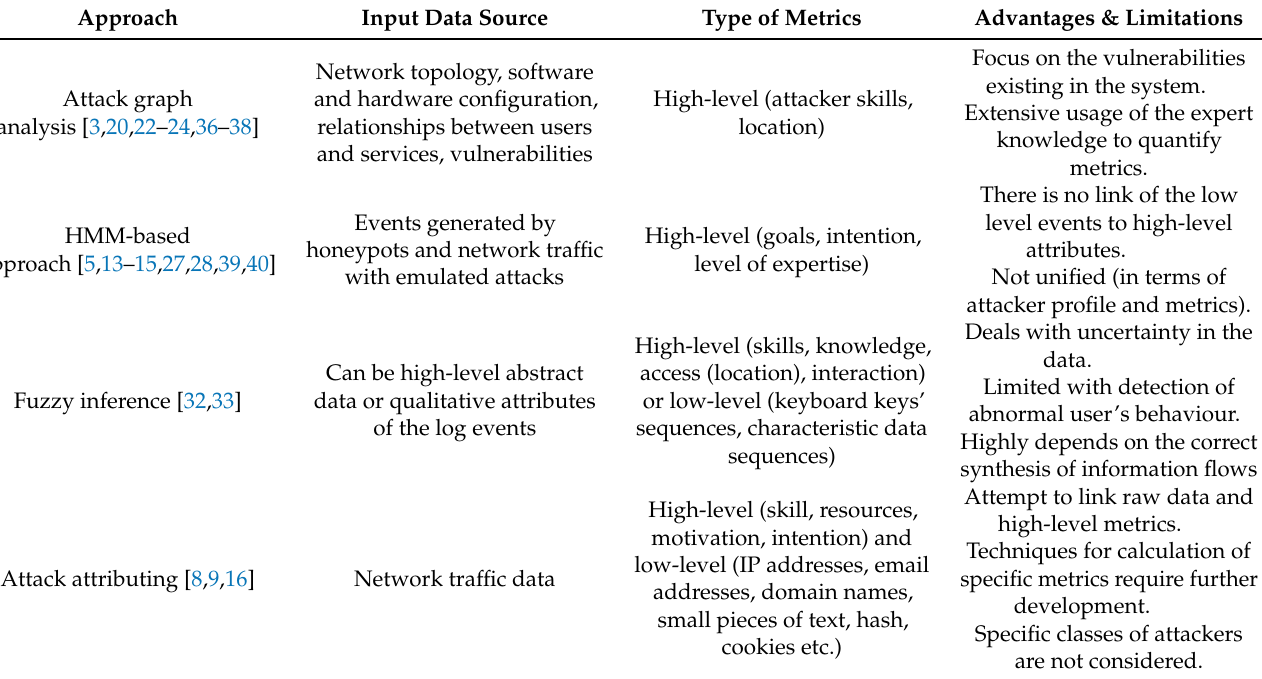
Table 1. Comparison of the existing approaches with the proposed